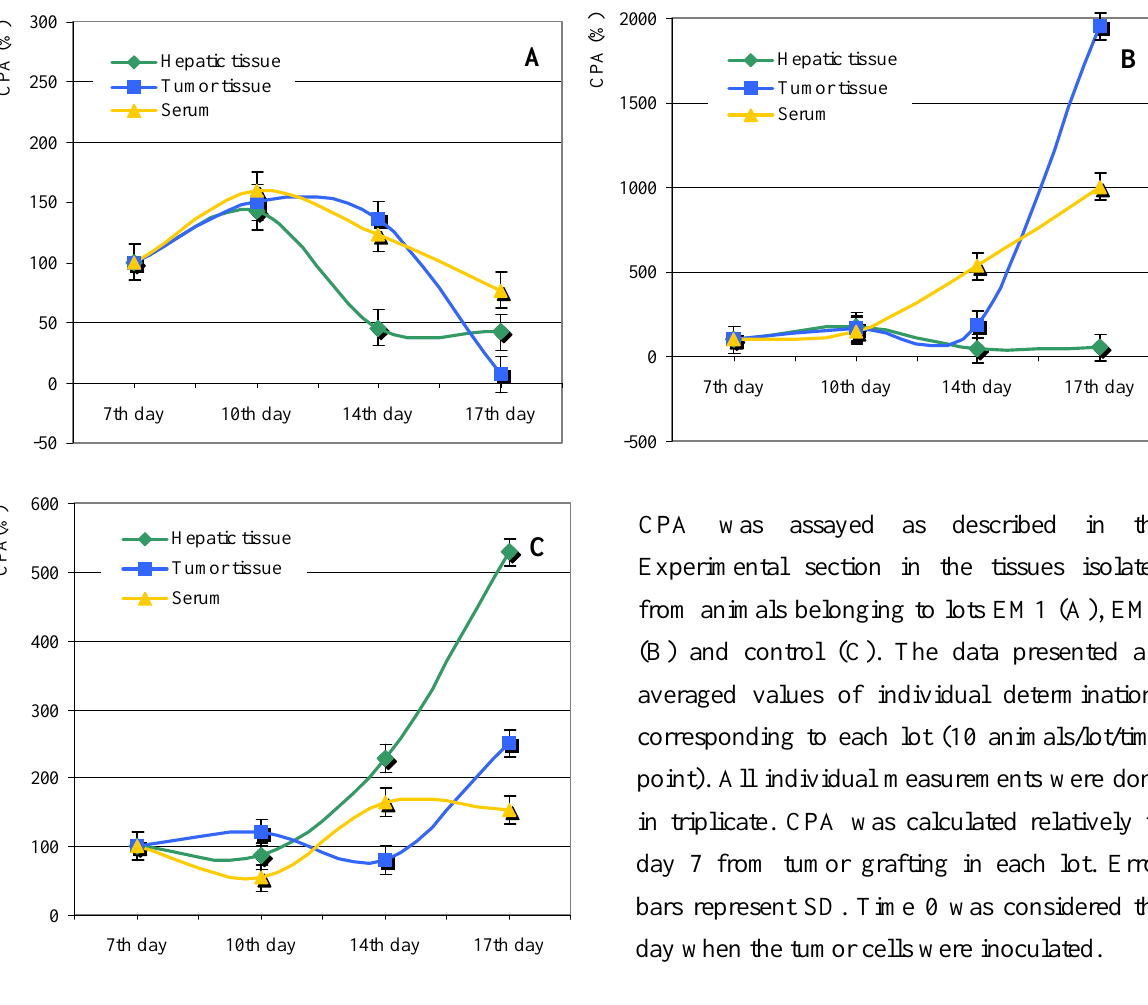
Figure 3 . Effect of Lonicera caerulaea berry extracts on ceruloplasmin activity (CPA).